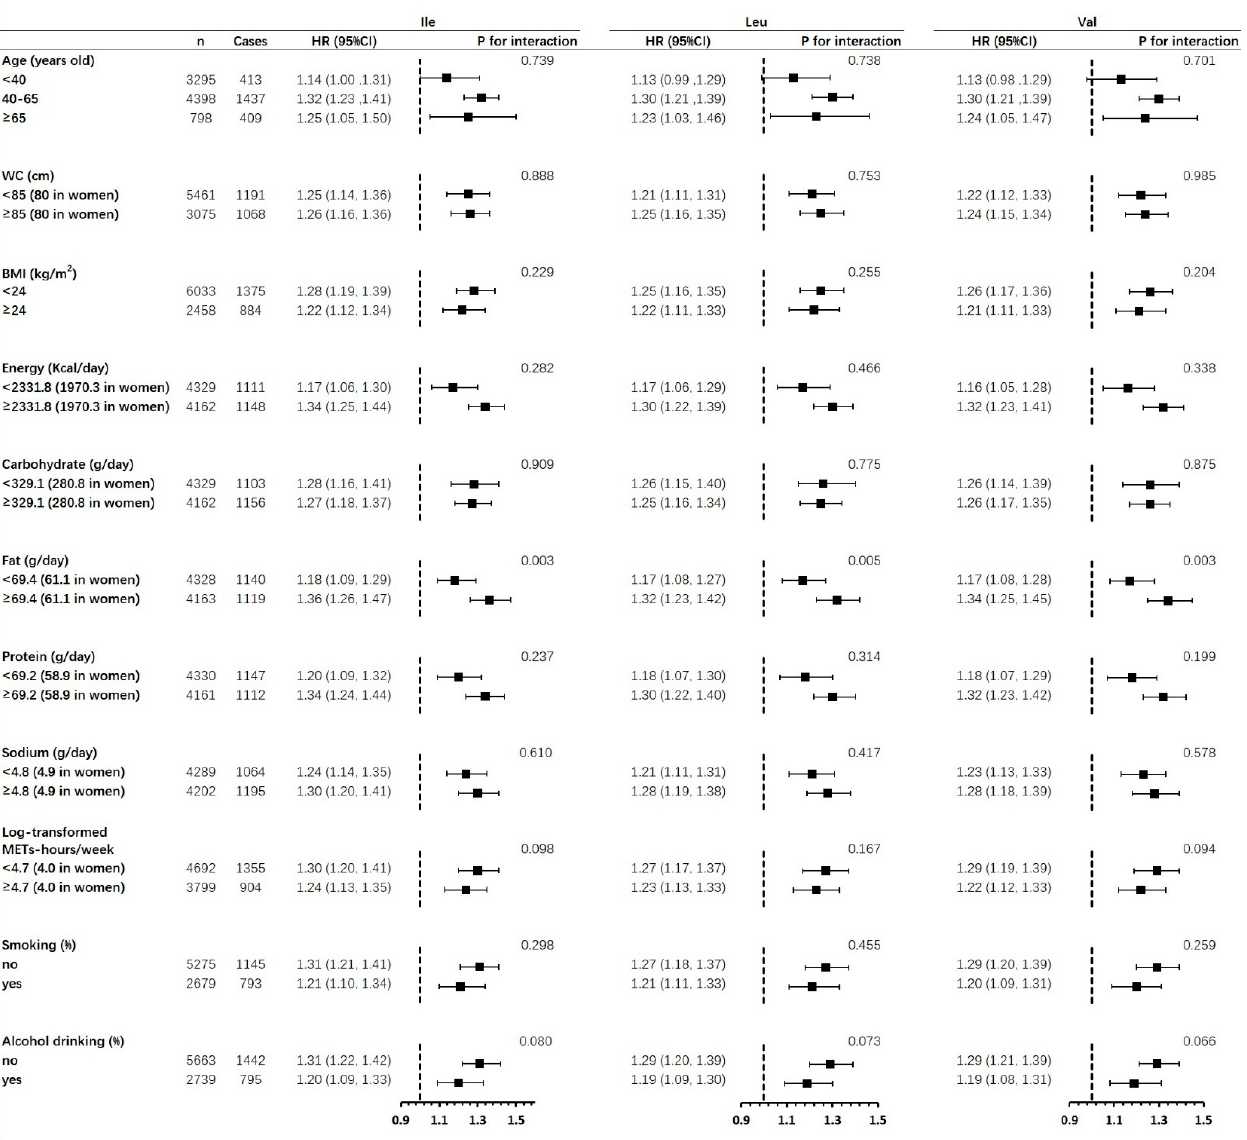
Figure 2. Stratified analysis of relationship between dietary BCAAs intake and hypertension risk based on confounders. HRs were estimated as per SD increase in BCAAs. Regression models were adjusted for age, gender, ethnicity, education, urban residents, diagnosed T2DM, physical activity, smoking, alcohol drinking, intakes of energy, carbohydrate, fat, protein, and salt intake. The interaction was only estimated for BCAAs, not for any other confounder. Abbreviations: BCAA: branched-chain amino acid; Ile: isoleucine; Leu: leucine; Val: valine; BMI: body mass index; WC: waist circumference; HR: hazard ratio; 95% CI: 95% confidence interval.